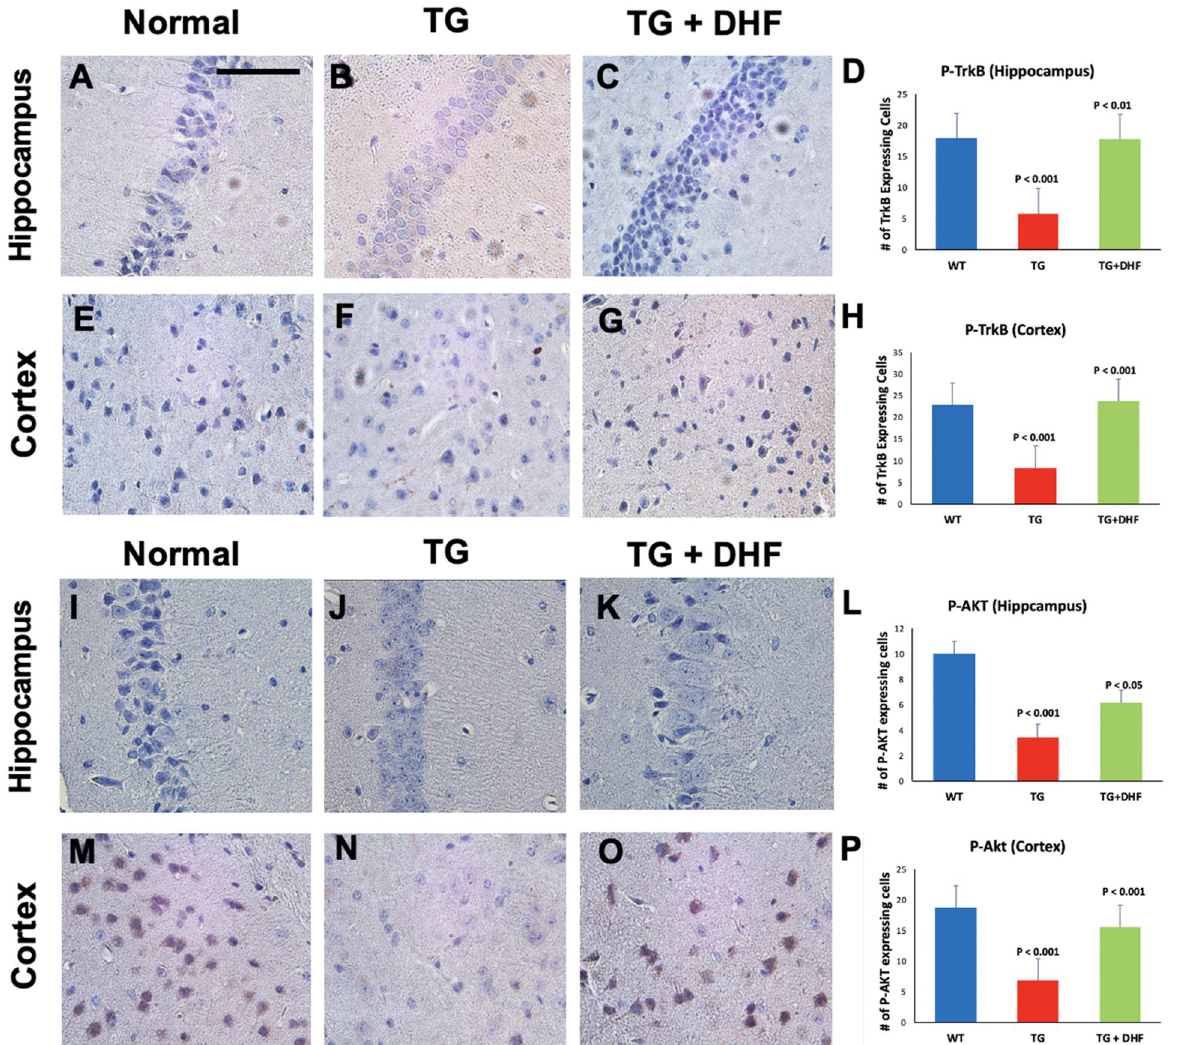
Figure 1. DHF treatment activates the TrkB/Akt pathway. P-TrkB and P-AKT expression in the hippocampus and cortex of Wild Type (WT), Tg26, and DHF treated Tg26 mice ( A – P ). Immunohistochemical stained sections show P-TrkB and P-AKT expressing cells in the hippocampal and cortex regions of the mice brains. 3 WT mice, 3 Tg26 mice, and 4 TG + DHF mice were used. A, B, C, E, F, G, I, J, K, M, N, and O are 400 × magnification pictures of the hippocampus and cortex regions of the mice. ( D ) Quantification of P-TRKB expressing cells in the hippocampus: p < 0.001, WT versus Tg; p < 0.01, Tg versus Tg + DHF. ( H ) Quantification of P-TRKB expressing cells in cortex: p < 0.001, WT versus Tg; p < 0.001, Tg versus Tg + DHF. One Way ANOVA with Bonferroni’s Multiple Comparison post-test. ( L ) Quantification of P-AKT expressing cells in the hippocampus: p < 0.001, WT versus Tg; p < 0.05, Tg versus Tg + DHF. ( P ) Quantification of P-AKT expressing cells in cortex: p < 0.001, WT versus Tg; p < 0.001, Tg versus Tg + DHF. The total numbers of hippocampal fields analyzed (WT, Tg26, TG + DHF) for each antibody were P-TrkB (34, 30, 30), P-AKT (45, 45, 60). The total numbers of cortex fields analyzed (WT, Tg26, TG + DHF) for each antibody were P-TrkB (15, 15, 20), P-AKT (45, 45, 60). One Way ANOVA with Bonferroni’s Multiple Comparison post-test. scale bar, 100